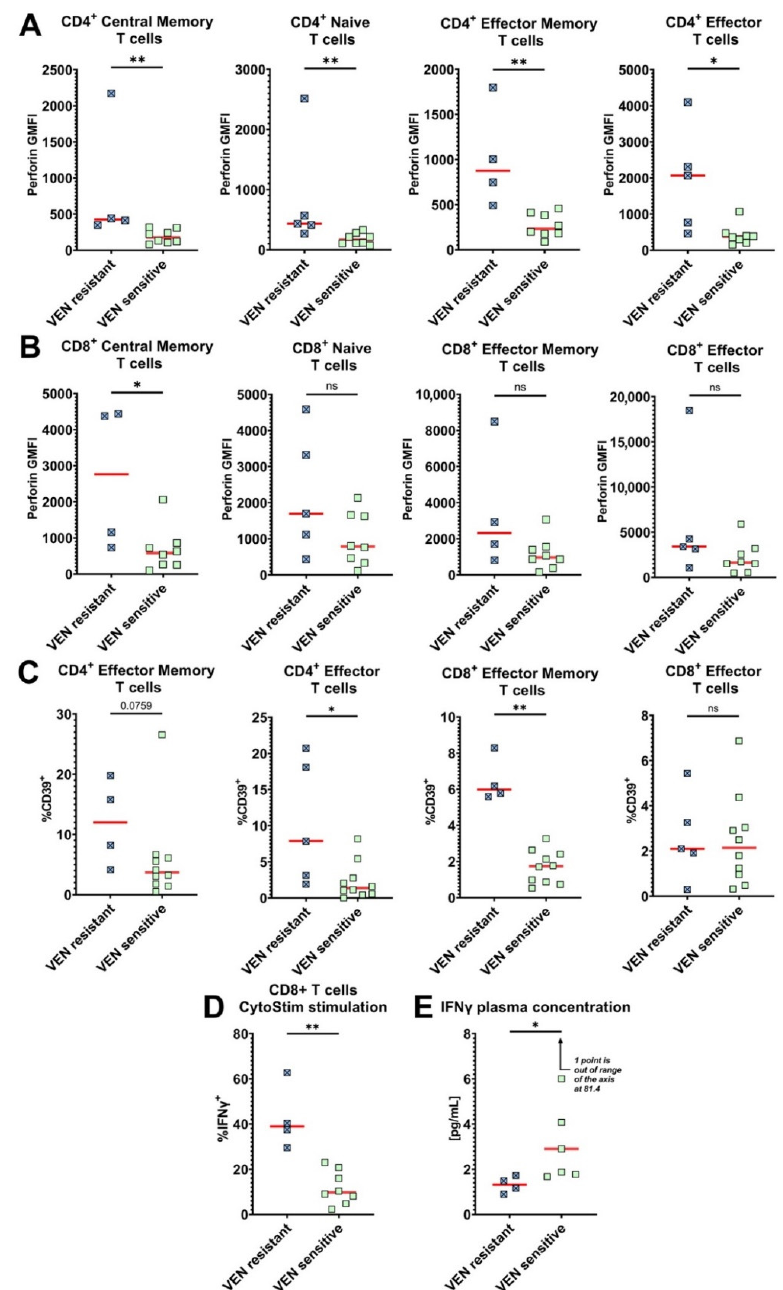
Figure 7. Distinct characteristics of T cells from venetoclax-resistant patients. The 15 patients treated with the combination of HMA/venetoclax were compared for different biomarker expression profiles. Five patients were venetoclax-resistant (VEN resistant), and ten were venetoclax-sensitive (VEN sensitive). One venetoclax-resistant patient (#14) lacked memory T cell subpopulations, so plots of effector memory and central memory T cells have four data points. ( A ) Intracellular GMFI expression of perforin by CD4 + T cells. ( B ) Intracellular GMFI expression of perforin by CD8 + T cells. Two patients in panels A and B were not assayed due to technical error. ( C ) Proportion of effector memory and effector T cells expressing CD39. ( D ) % IFN- γ -producing CD8 + T cells after in vitro stimulation with CytoStim. Three patients were not assayed due to low PBMC availability. ( E ) The level of IFN- γ in plasma from venetoclax-resistant and venetoclax-sensitive AML patients. MesoScale-based analysis was performed for 11 HMA/venetoclax- treated patients. Red bars represent medians. Mann–Whitney nonparametric U test was used for statistical analysis. ns— p > 0.05; *— p < 0.05; **— p < 0.01. A p -value is specified when it is close to